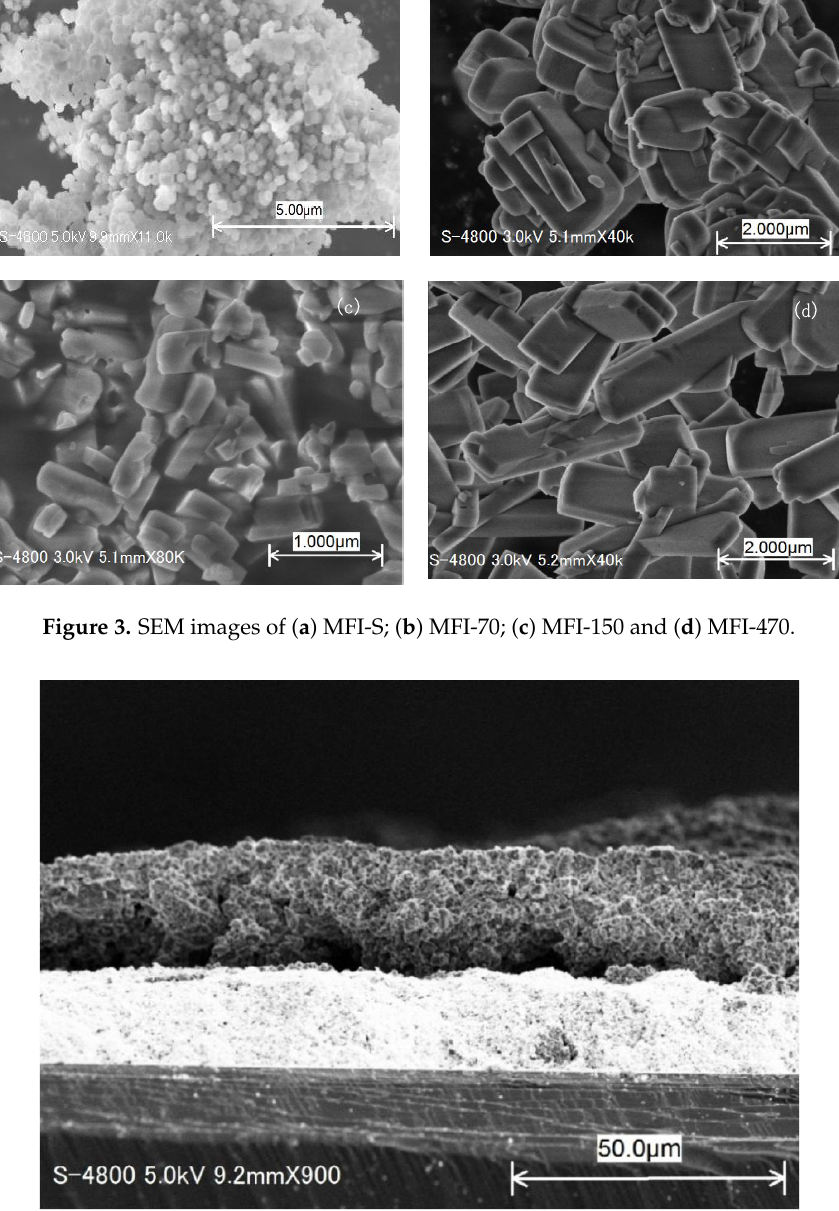
Figure 4. Cross-sectional SEM image for ZSM-5 coated SnO 2 sensor.